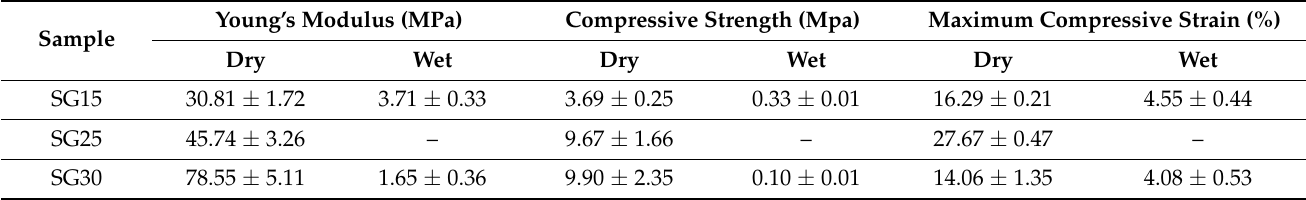
Table 3. Elastic parameters of the hybrid aerogels tested under uniaxial compression, as obtained (in the dry state) and submerged in PBS (in the wet state).